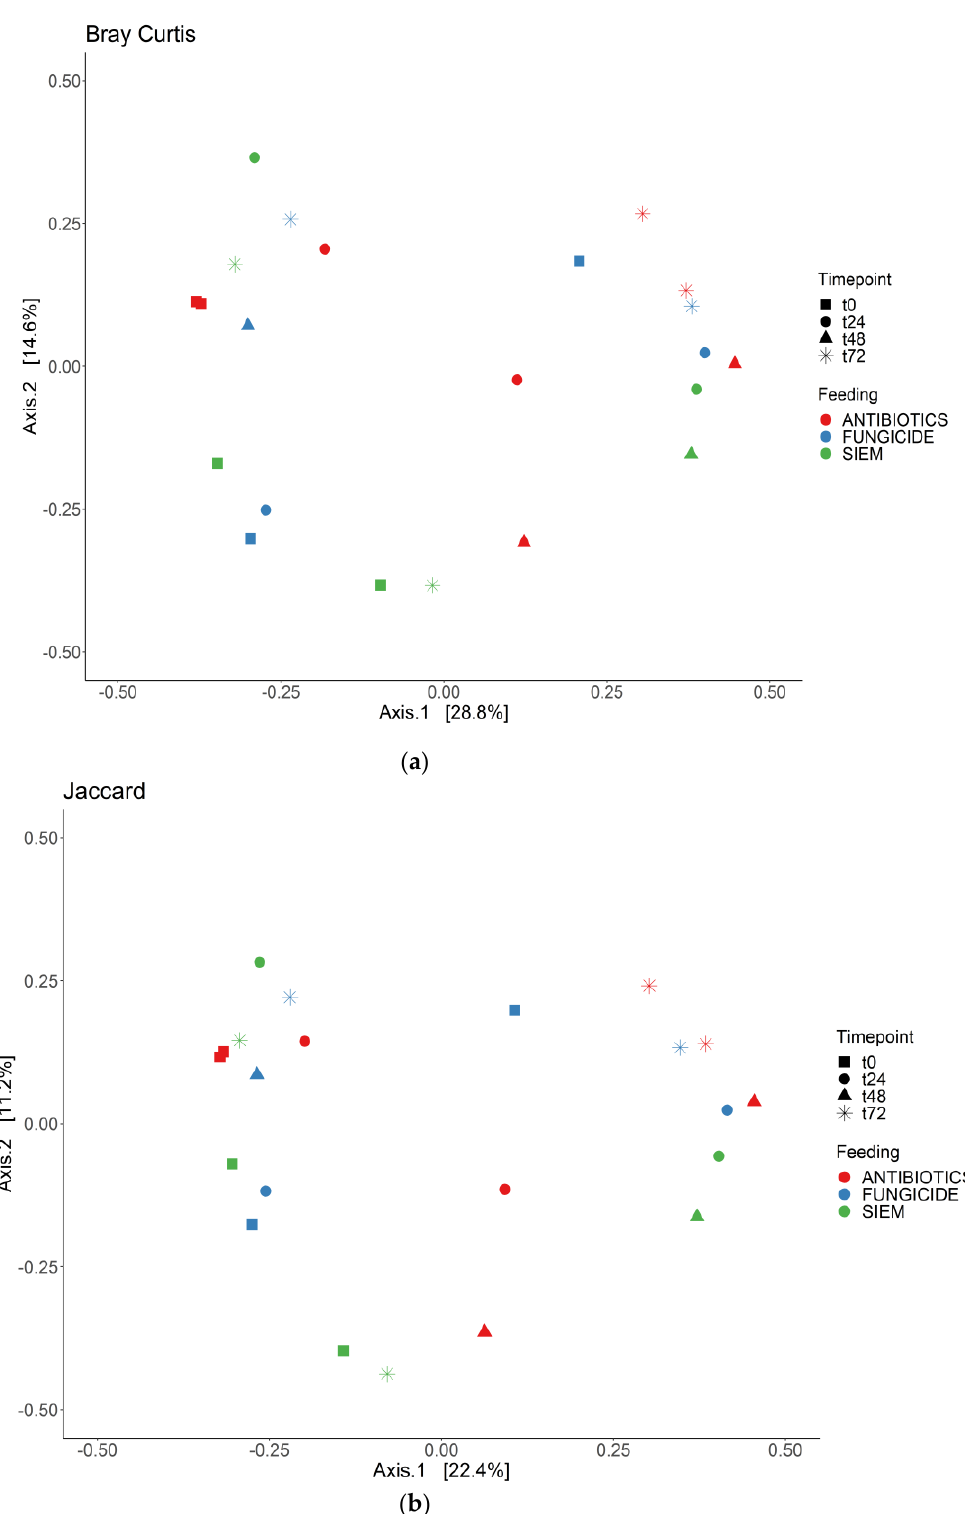
Figure 4. PCoA for fungi; ( a ) Bray Curtis dissimilarity; and ( b ) Jaccard. In addition to the diversity analyses, taxonomic classification of samples was also done. In Figure 5, the bacterial relative abundance for the different samples is shown at the phylum and genus level. The most abundant phyla found in all samples were Bac- teroidetes and Firmicutes (Figure 5a) . No big shifts could be seen for the different treat- ments. The 20 most abundant genera are also shown; in these genera also, no significant